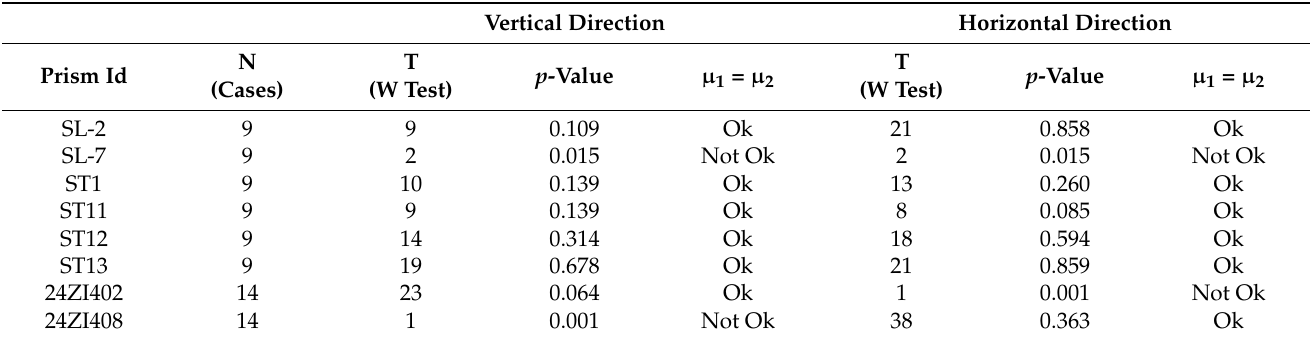
Table 7. Wilcoxon statistic test of the vertical and horizontal S1-Proj. Vertical Direction Horizontal